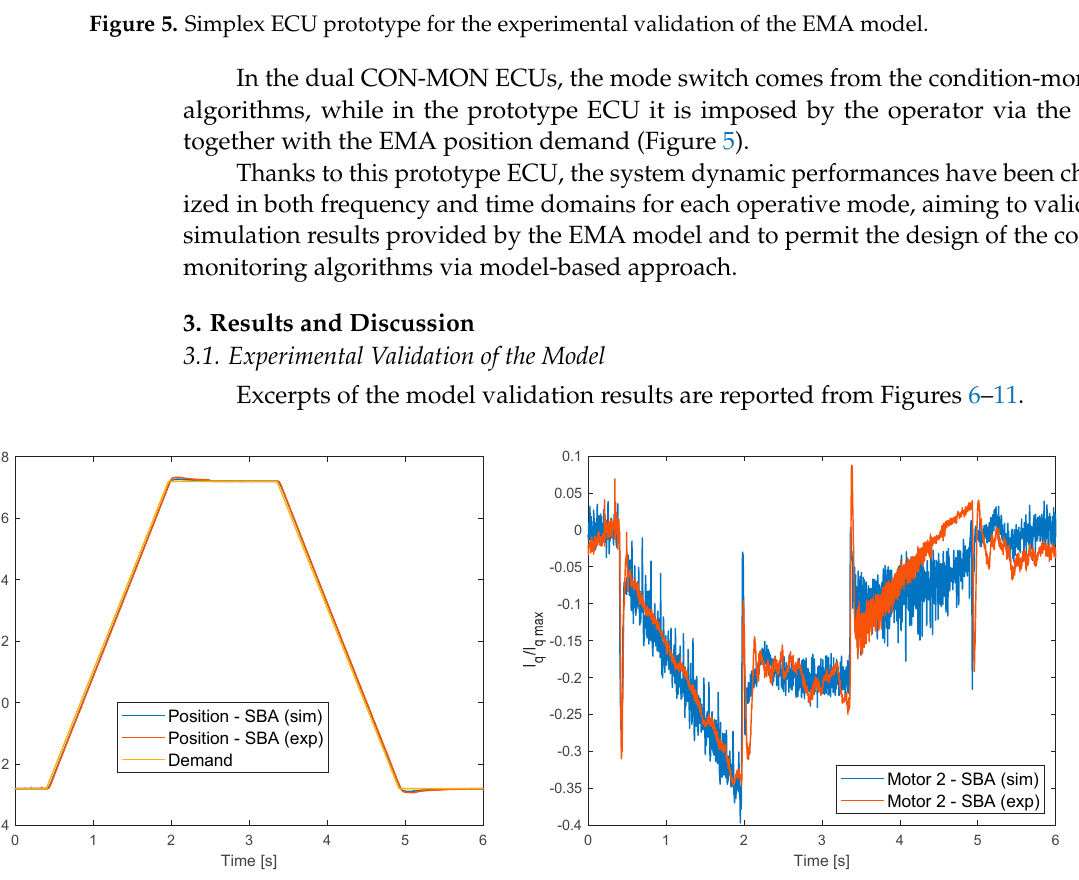
( b ) Figure 7. Time-domain model validation: position tracking in ASB mode with 100 kN/m spring-type loading (in Equation (24), k e = 10 5 N/m); ( a ) output position; ( b ) motors quadrature currents ( x o max = 25 × ∙ 10 − 3 m; I q max = 25 A).